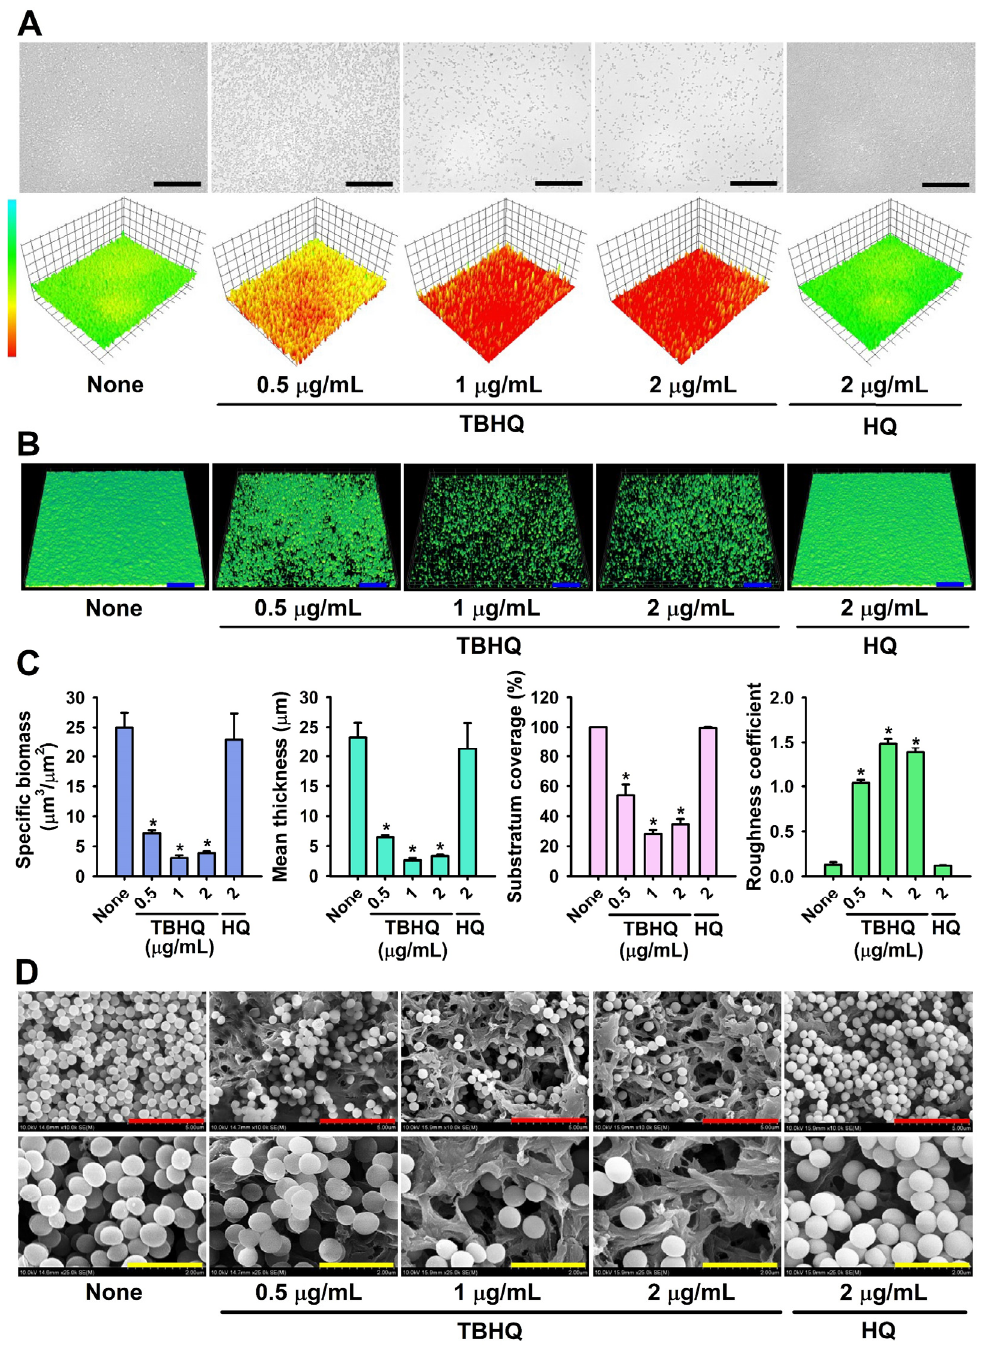
Figure 2. Microscopic observations of S. aureus biofilm inhibition by TBHQ. Constructed color- coded 3D images of MSSA 6538 biofilms after culture with TBHQ or HQ ( A ), CLSM images ( B ) and COMSTAT analysis ( C ), SEM analysis ( D ). Error bars represent standard deviations. * p < 0.05 vs. non-treated controls (None). The black, blue, red, and yellow scale bars represent 50, 100, 5, and 2 µm, respectively.